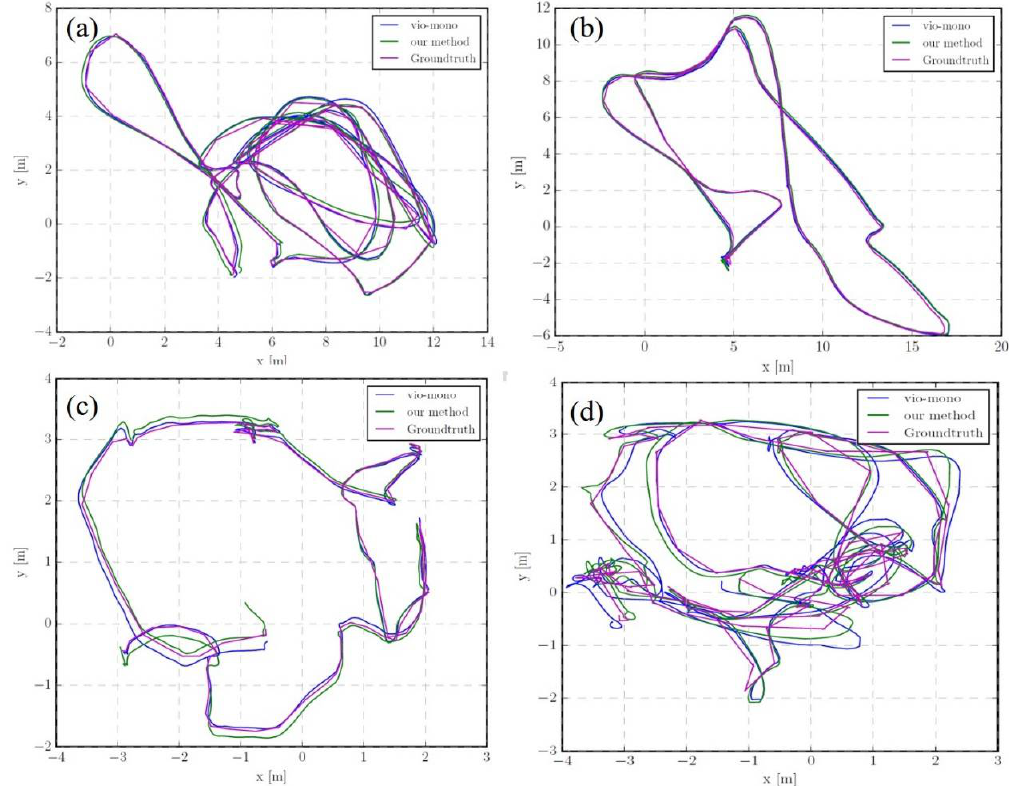
Figure 5. Trajectory compared with VINS in ( a ) MH_03_median, ( b ) MH 05 difficult, ( c ) V2_01_easy, and ( d ) V2_02_median.